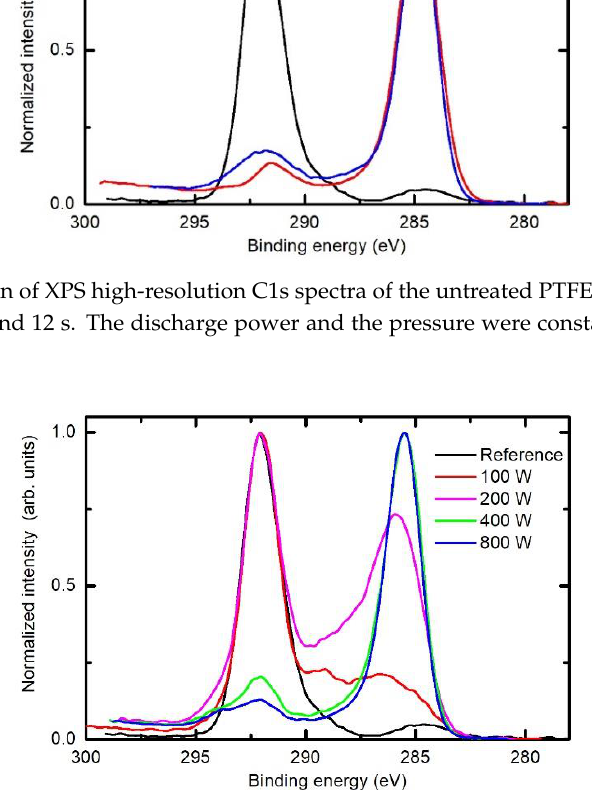
Figure 10. Comparison of the selected XPS high-resolution C1s spectra of the PTFE samples treated for various powers. The treatment time and the pressure were constant at 1 s and 25 Pa, respectively.